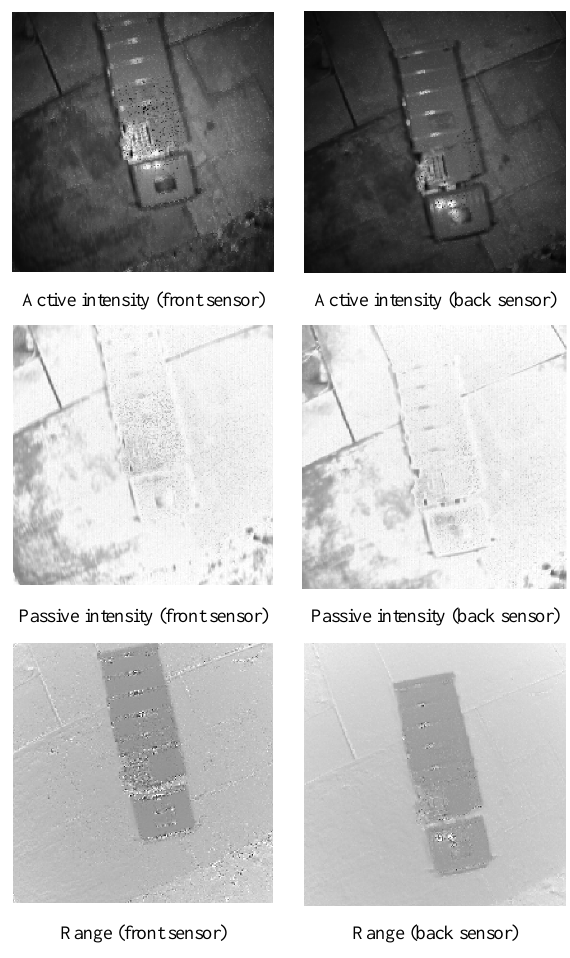
Figure 9. Image results of the parallel acquisition geometry. Again the captured images are converted to a point cloud and visualized now in Figure 10. Similar to the convergent case, the